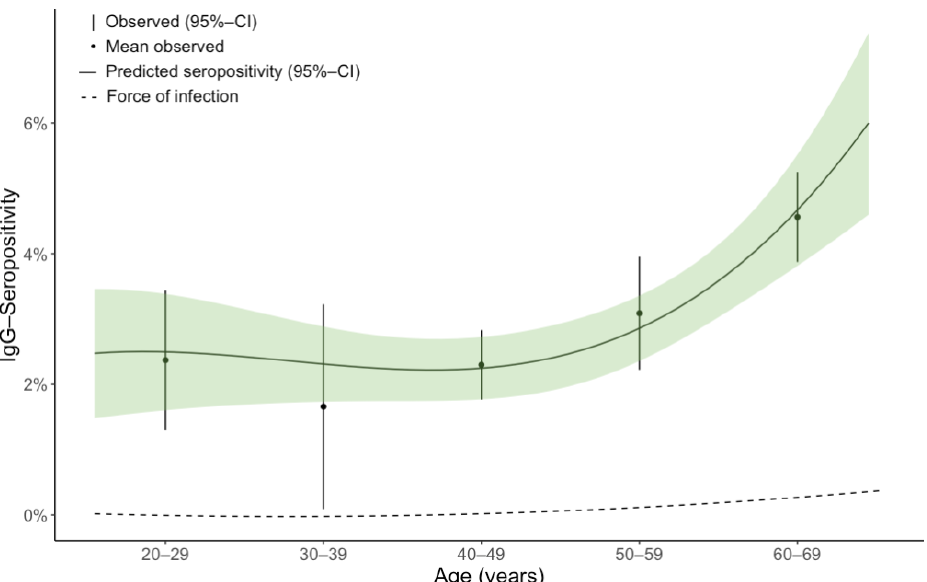
Figure 2. Observed IgG seropositivity for B. burgdorferi s.l. with the force of infection (FOI) model-predicted seropositivity; IgG = Immunoglobulin G; observed seropositivity presented as error bars for 10-year age groups with mean value and 95% confidence interval; Grenfell and Anderson’s FOI [43] presented as a dashed line, representing the average change in the population’s seropositivity proportion. FOI model seropositivity predictions as a solid line with a 95% confidence interval (green).